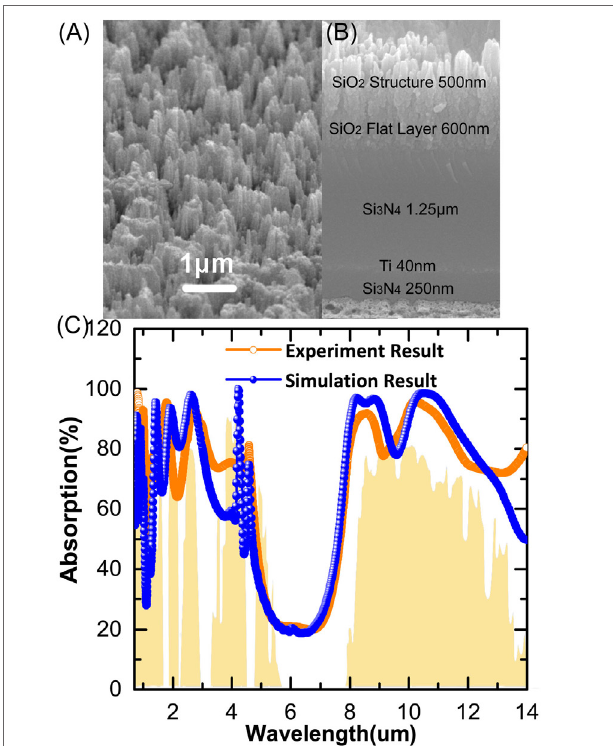
FigUre 5 | SEM pictures of (a) the top view and (B) the side view of the fabricated structure. (c) The simulated and experimental absorption results of the optimized hierarchical structure, in comparison with the atmospheric transmission spectra from 0.7 to 14